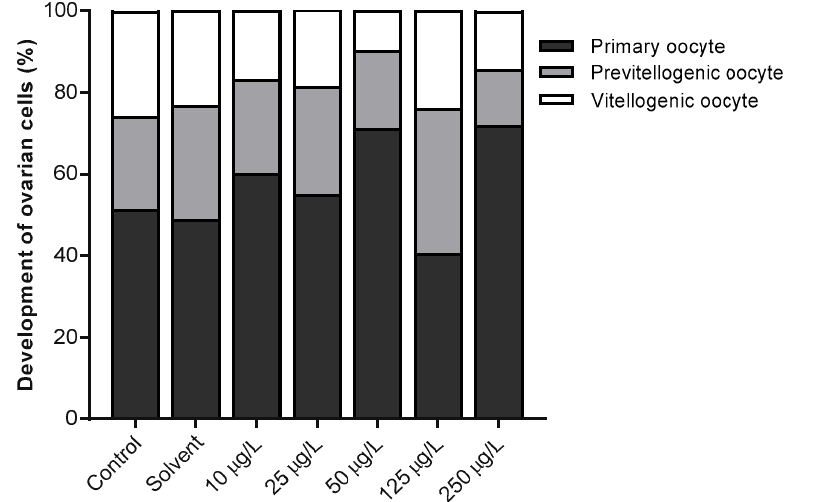
Figure 4. Development of oocyte in Javanese medaka (n = 3) at 21 days post-exposure to 3,4-DCA.